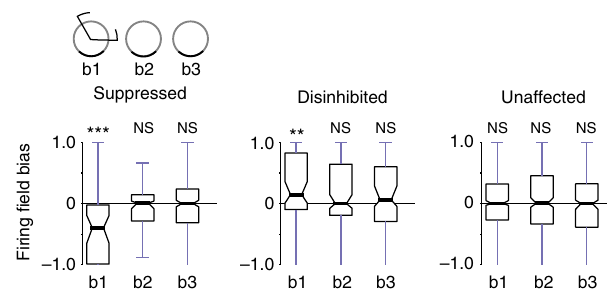
Figure 7 | Firing field bias for individual exploration sessions in novel environment. Boxplots of firing rate bias for each group of neurons is shown. All place map bins with firing rates 4 1Hz were included in the firing fields. A negative bias indicates smaller firing field inside as compared with outside the light zone in the same session. Binomial test, suppressed cells: b1: *** P o 0.0000001, b2: P ¼ 0.7665, b3: P ¼ 1.0000; disinhibited cells: b1: ** P ¼ 0.0086, b2: P ¼ 1.0000, b3: P ¼ 0.5258; unaffected cells: b1: P ¼ 0.8392, b2: P ¼ 0.4926, b3: P ¼ 0.8439. * P o 0.05, ** P o 0.01, *** P o 0.001. NS, not